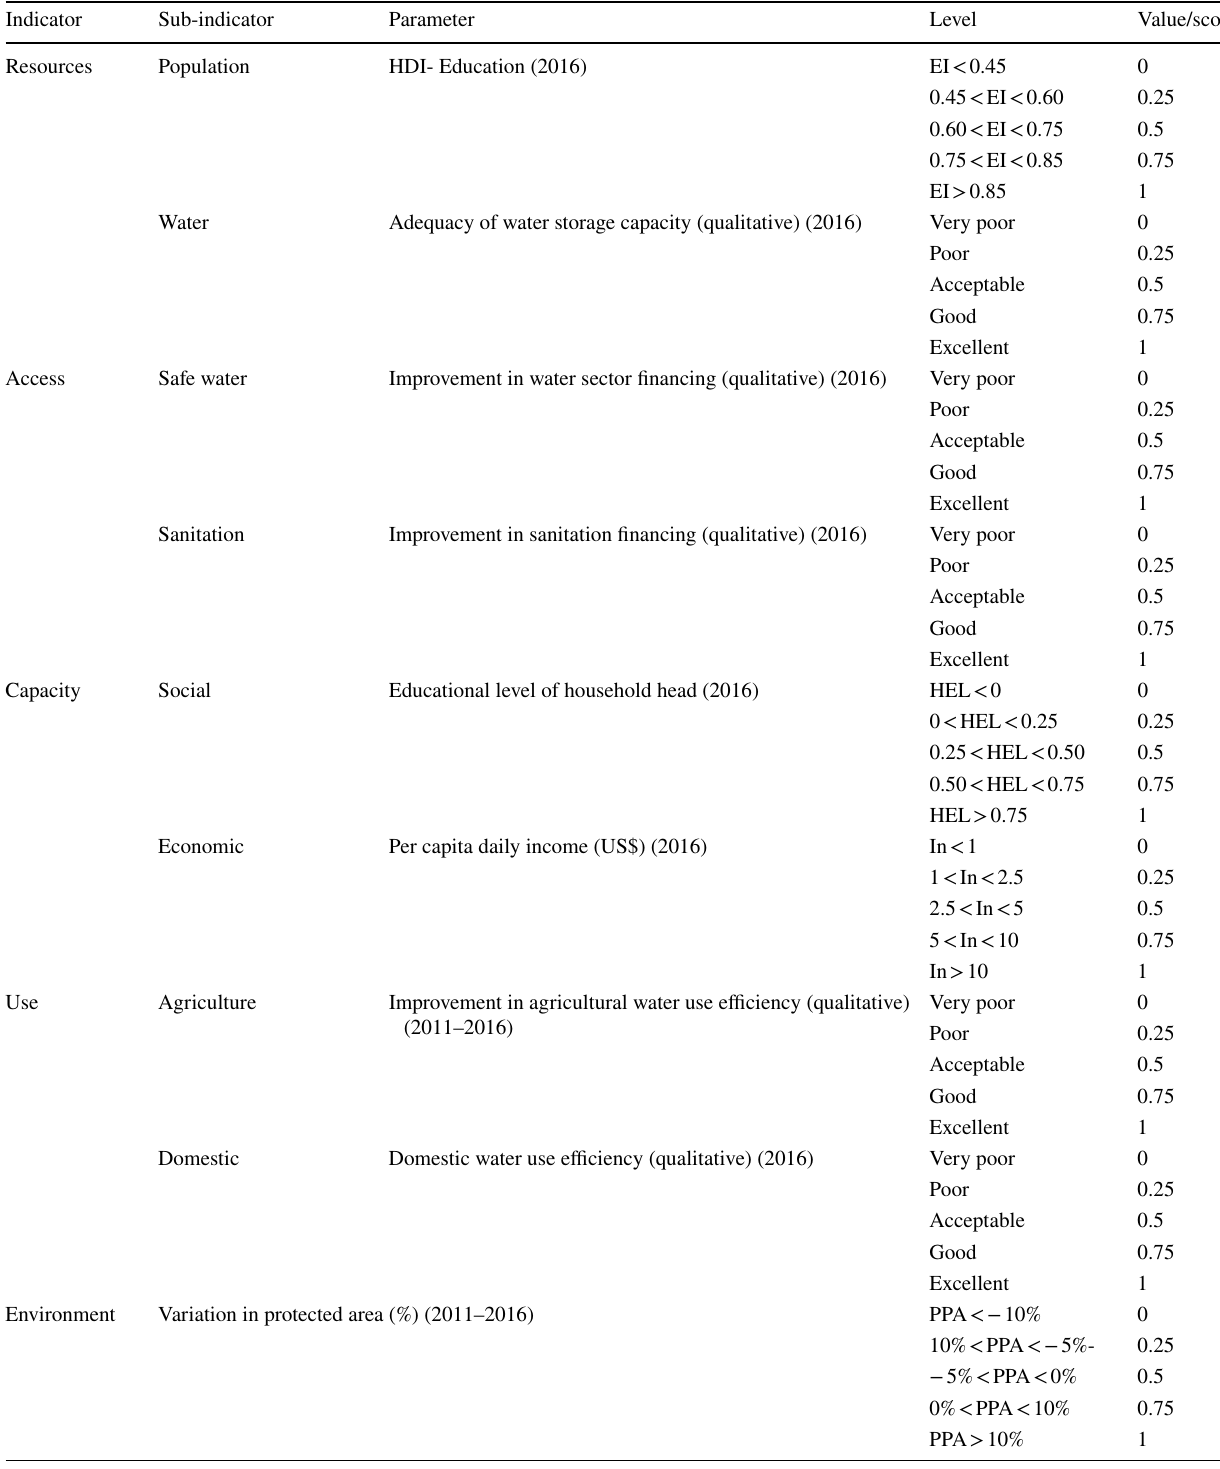
Table 3 eWPI Response parameters and their values Indicator